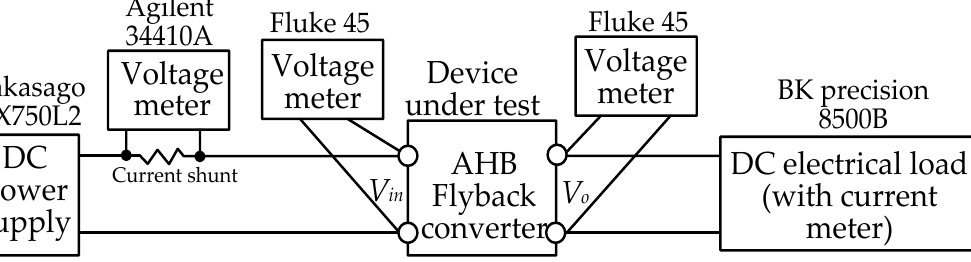
Figure 7. Measurement setup of the system test.